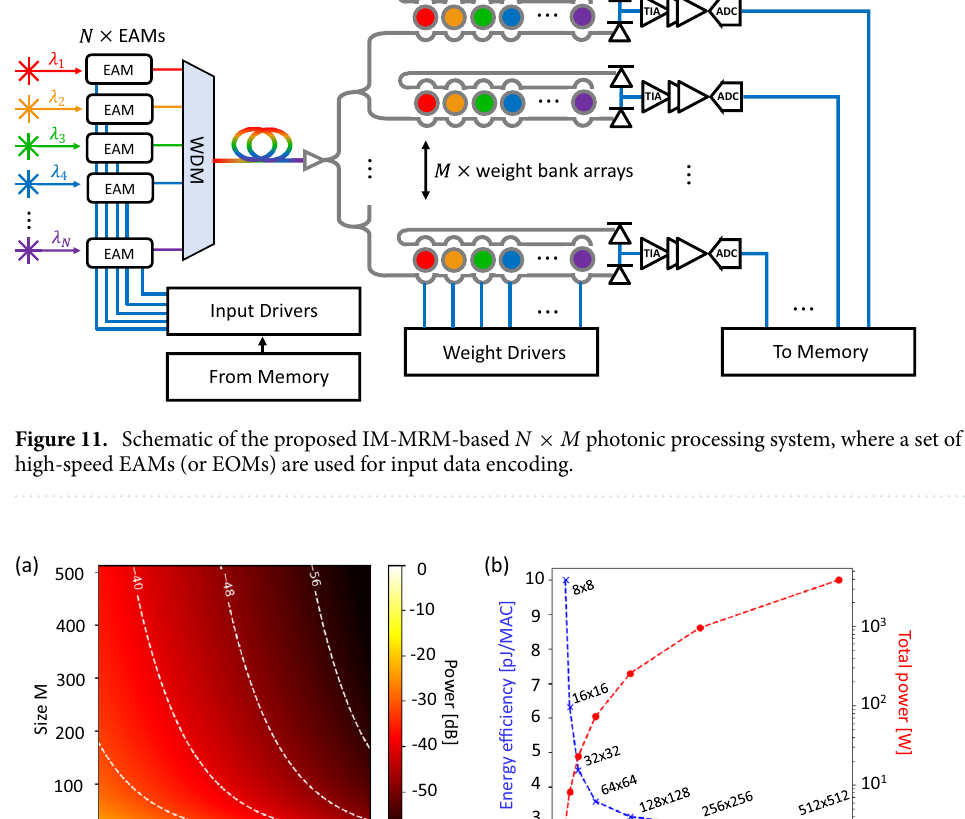
M photonic processing system with 3-dB inter-channel crosstalk Figure 12. ( a ) Optical link budget of an N × penalty when N and M vary from 0 to 512. ( b ) Total energy efficiency (blue) and power consumption (red) of a square-size ( N = M ) photonic processing system with a fixed precision of 8.5